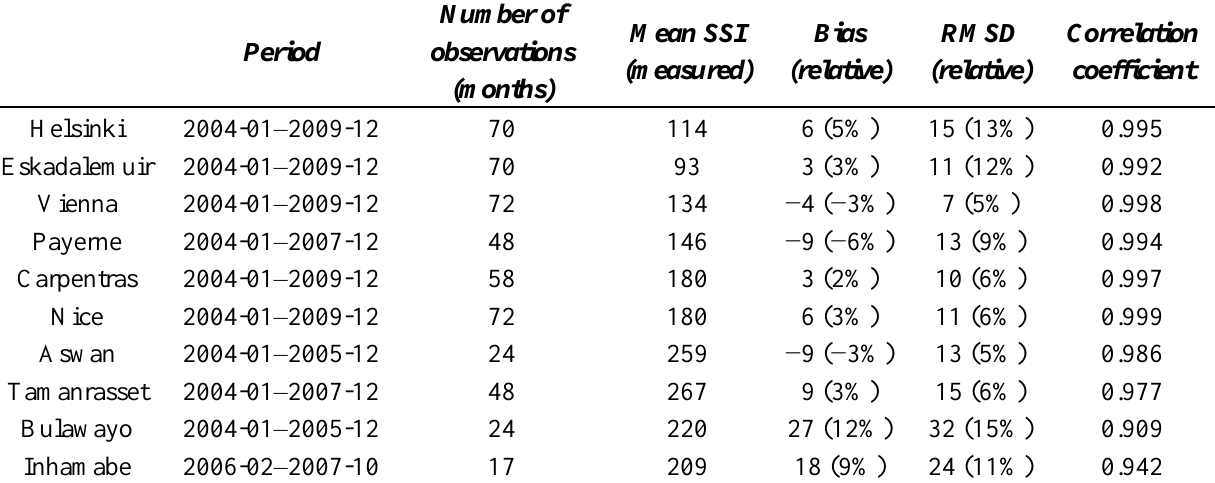
Table 5. Comparison between HC-3 and ground-based measurements of monthly mean of SSI (in W/m²). RMSD: root mean square difference. In brackets, quantities are relative to the mean SSI. Number of Period